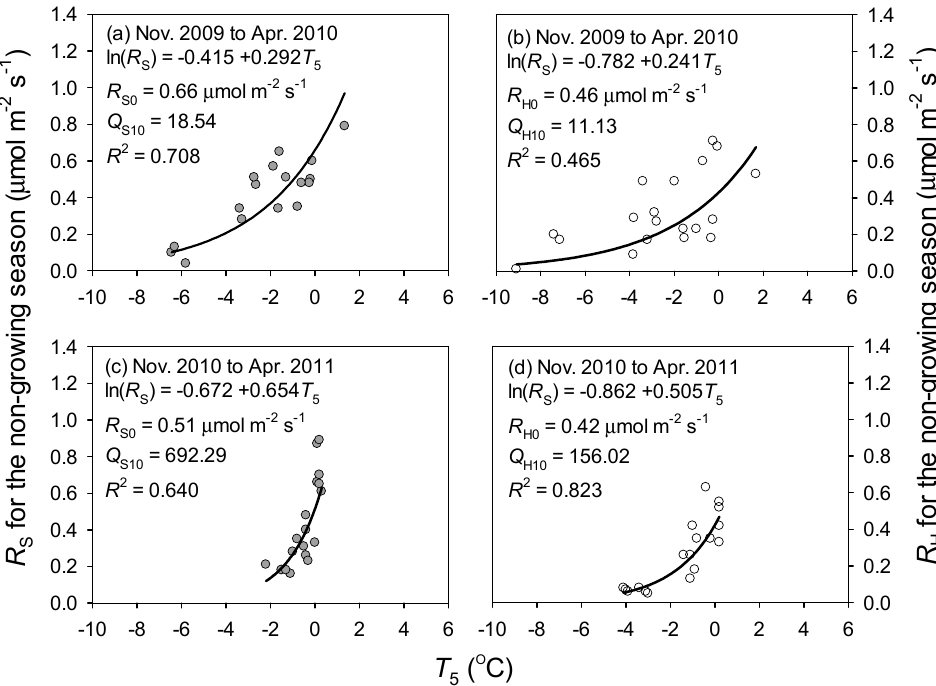
Figure 2. Relationships between soil temperature at 5 cm depth ( T 5 ) and ( a , c ) soil CO 2 effluxes ( R S ) and ( b , d ) CO 2 efflux from trenched plots ( R H ) during the non-growing season. The R S0 and R H0 are normalized respiration rate at 0 °C for R S and R H , respectively, and Q S10 , Q H10 are temperature sensitivities for R S and R H , respectively. All p -values of the regression models were <0.001. Forests 2018 , 9 , x FOR PEER REVIEW The R S0 and R H0 for the growing season (0.60–1.00 μ mol m − 2 s − 1 ) were slightly higher than those for the non-growing season (0.42–0.66 μ mol m − 2 s − 1 ), whereas Q S10 and Q H10 (2.34–3.06) were much lower than those for the non-growing season (11.13–692.29) (Figures 2 and 3). The interannual differences in R S0 and R H0 , as well as Q S10 and Q H10 for the growing season, were consistent with those for the non-growing season. For both growing seasons, R S0 was higher than R H0 and Q S10 was larger than Q H10 .